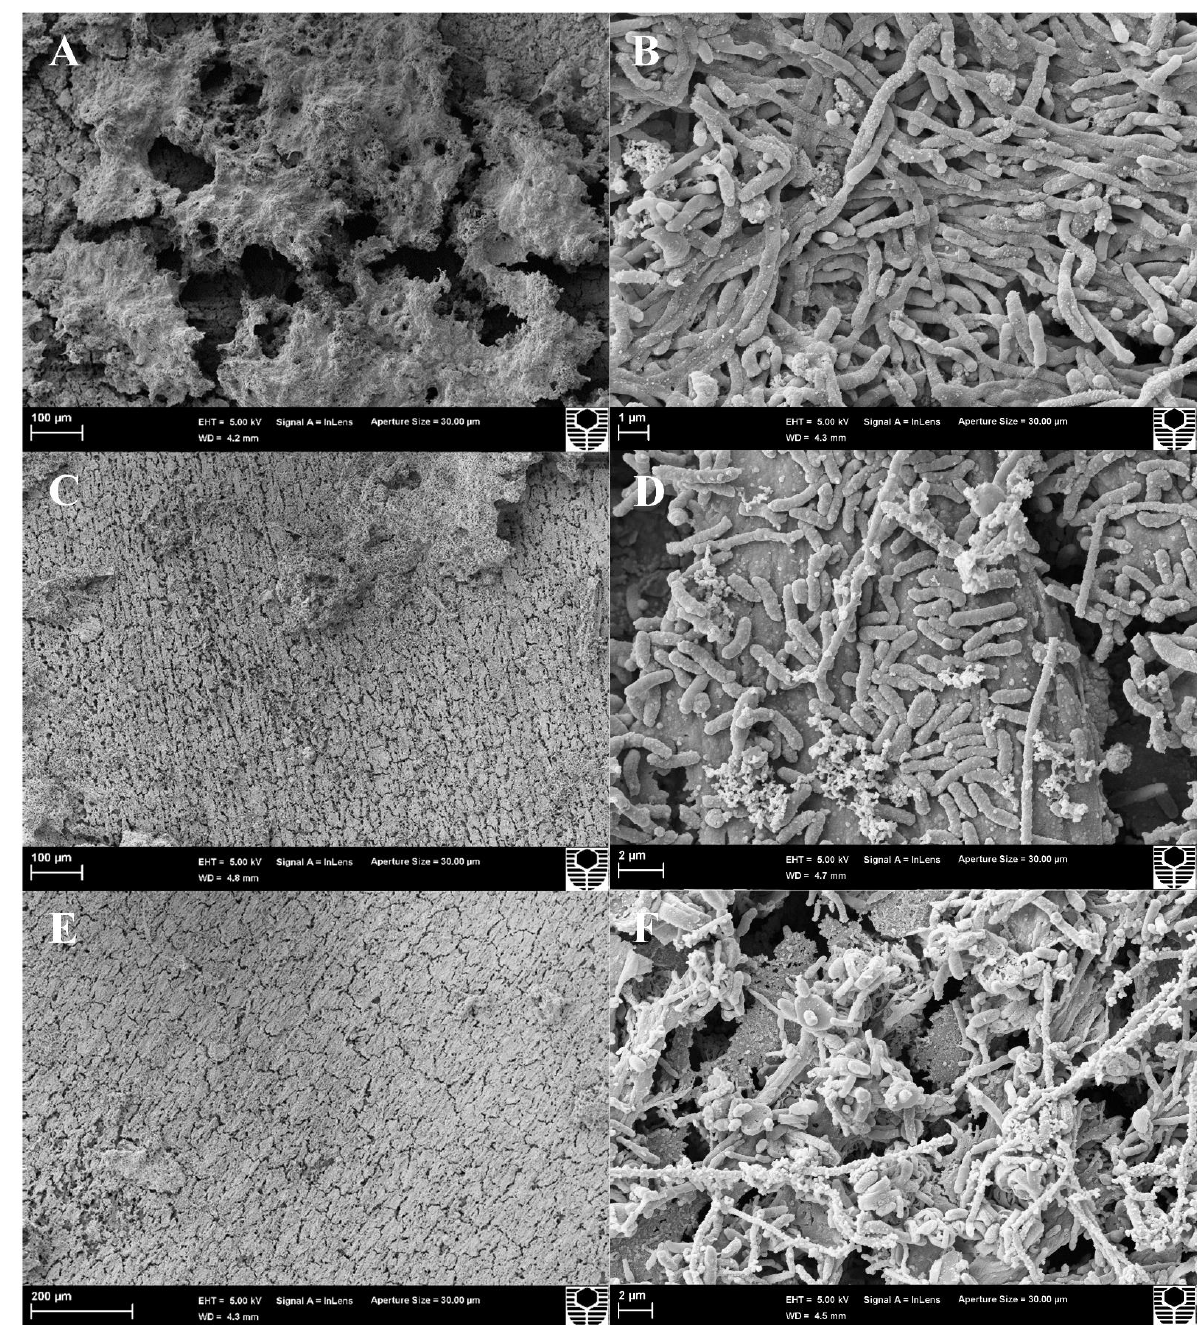
Figure 4. Scanning electron microscopy of biofilms before treatment ( A , B ), after treatment with 1 mM CTA-4OHcinn ( C , D ) and after dual treatment with 1 mM CTA-4OHcinn and DNase ( E , F ). Micrographs on the left of the figure depict the biofilm under low magnification to show a larger sur- face area, and micrographs on the left depict the cell arrangement within the biofilm. CLSM and SEM observations were supported by viability assays (Figure 5A), indi- cating that 1 × 10 8 viable cells could be extracted per cm 2 of coupon surface area in exper- imental (biological) replicates. Measurements of tATP are proportional to viability and